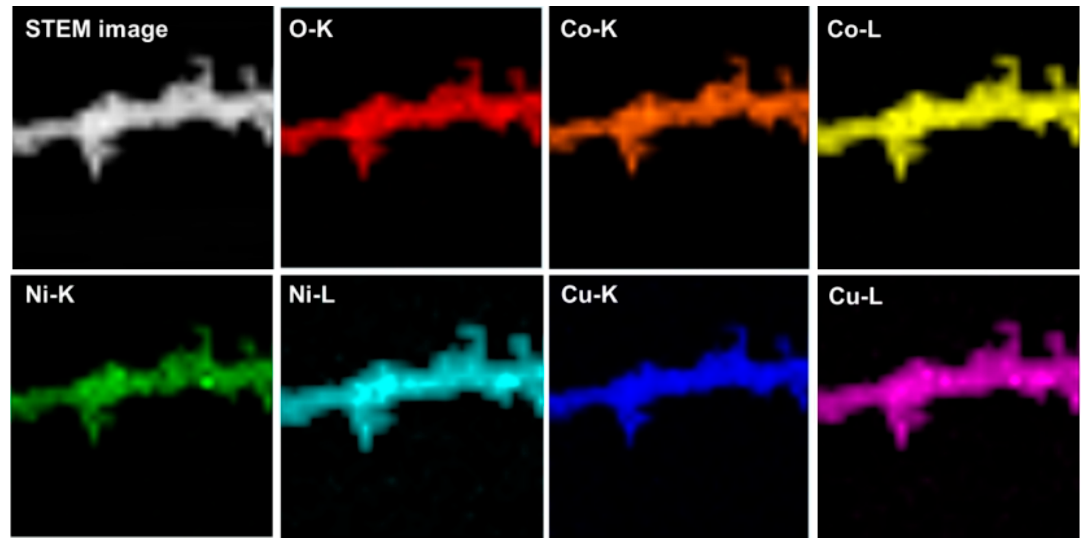
Figure 4. Elementary mapping of Cu 0.6 Ni 0.4 Co 2 O 4 .